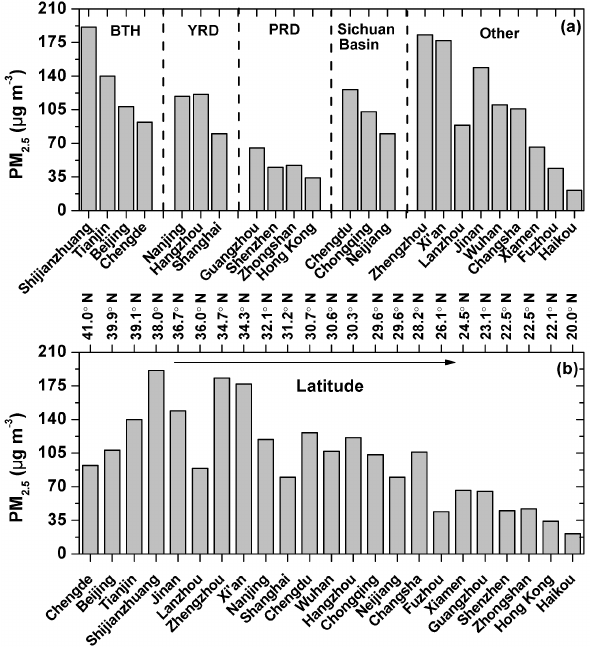
Figure 2. Annual PM 2 . 5 mass concentration in various Chinese cities with filter-based measurements: (a) categorized into regions and (b) lined with